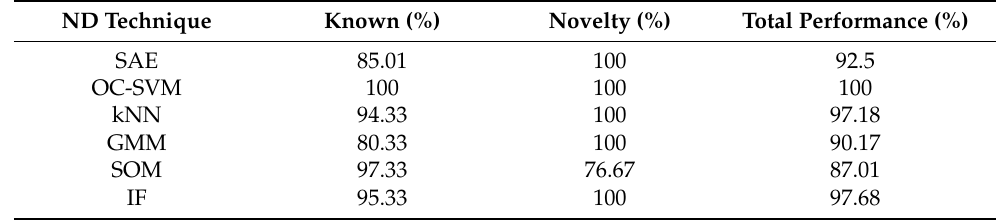
Table 11. Numerical results of the novelty detection obtained for the second case study of the